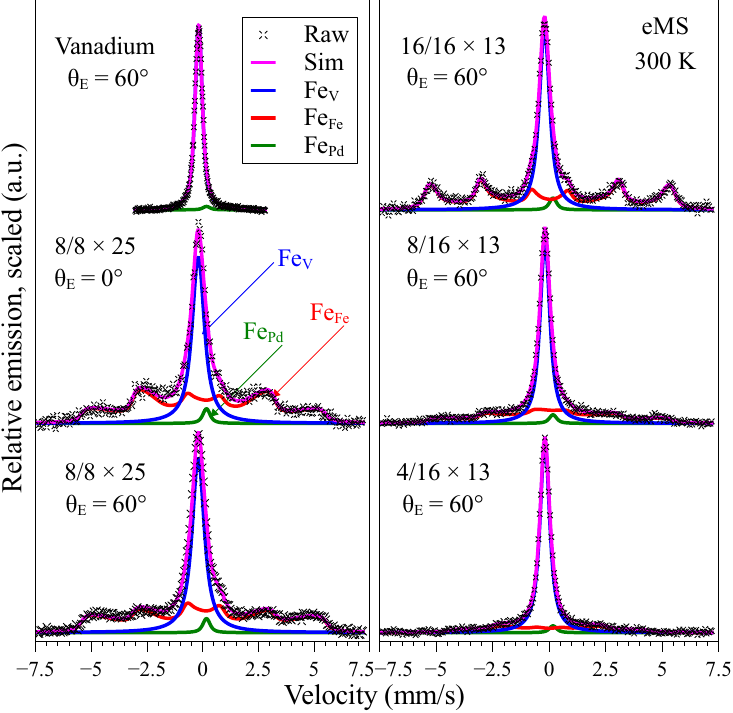
Figure 4. 57 Fe + eMS spectra of the Fe/V superlattices and the pure vanadium sample at 300 K. Emission angles ( θ E ) relative to the sample surface normal are